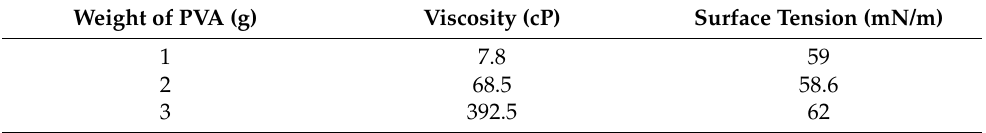
Table 1. Viscosity and surface tension of ink solutions with different weights of PVA.